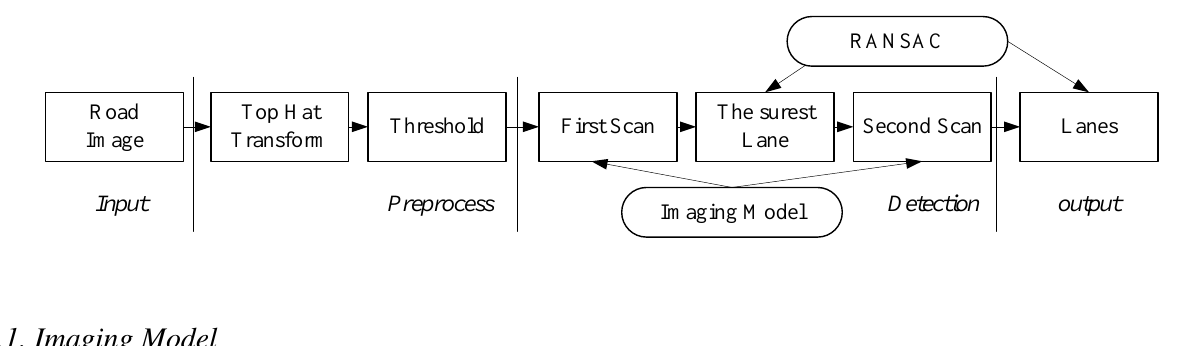
Figure 4. Flowchart of two scans based lane detection